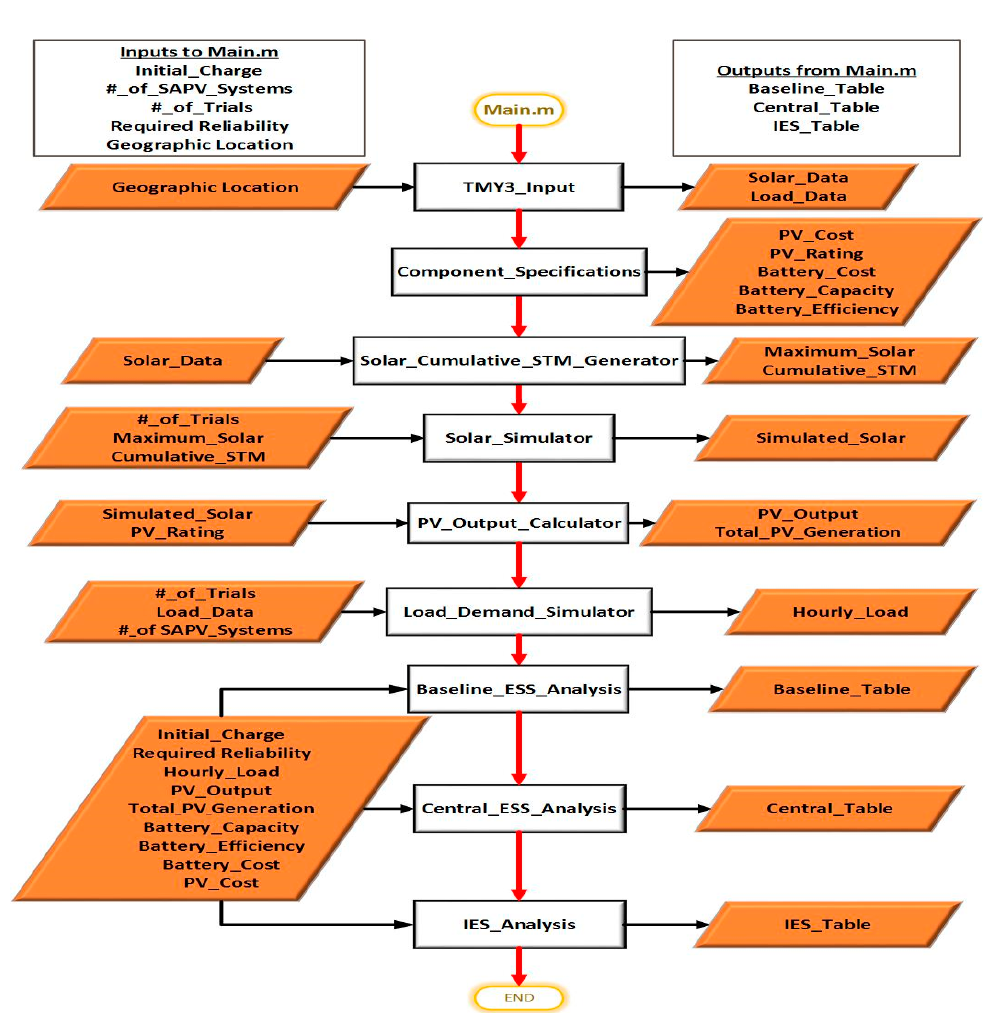
Figure A1. Major inputs (on the left), functions (in the middle), and major outputs (on the right) for main project file. Table of results for baseline, CES, and IES is the final output.